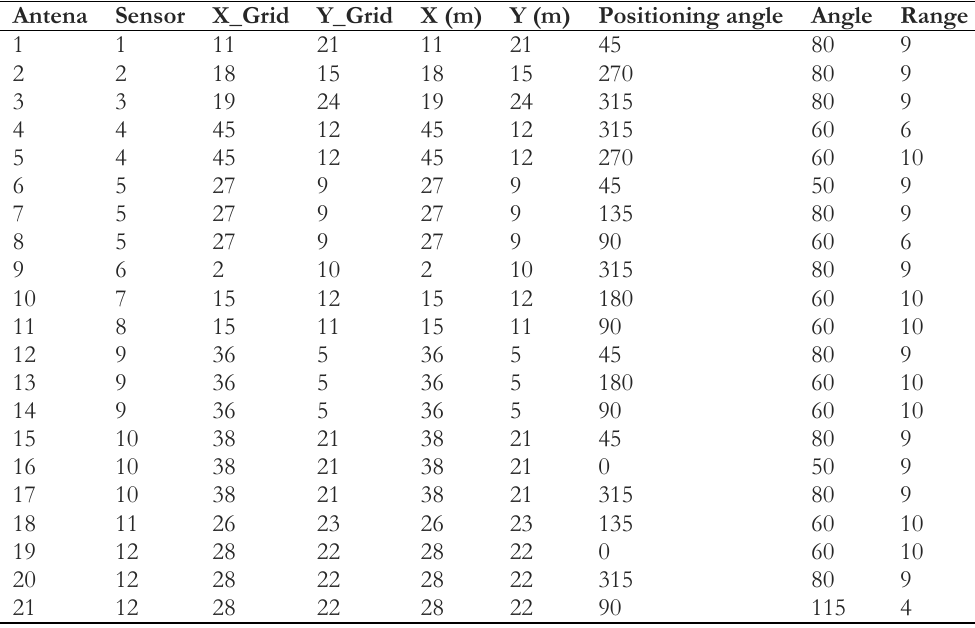
Table 11. Optimized antenna design for scenario 3.